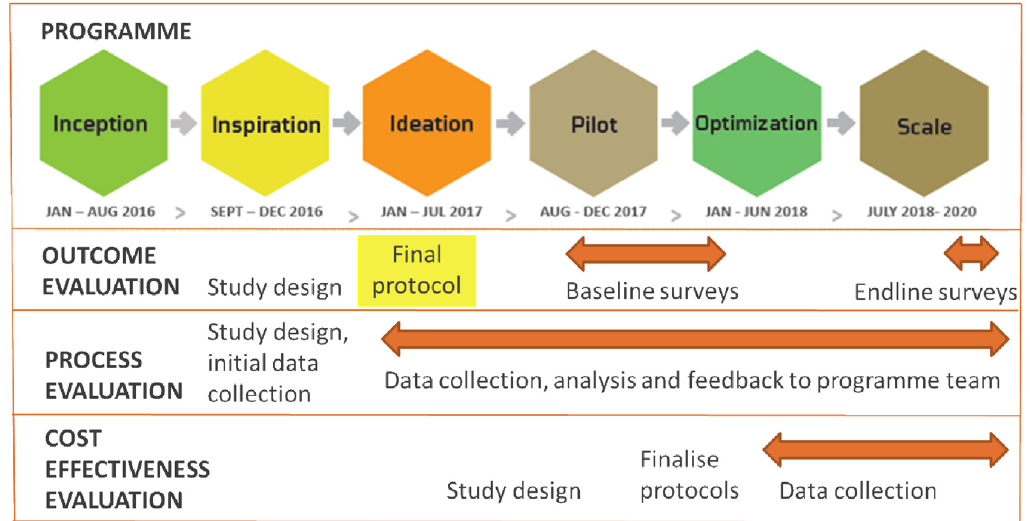
Figure 3. Timeline of A360 intervention development and implementation and the external